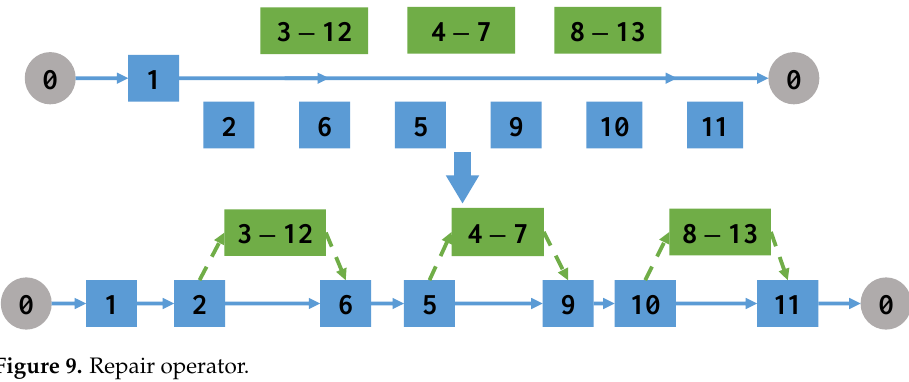
Figure 9. Repair operator.